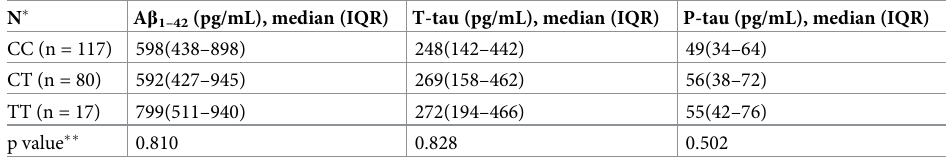
Table 4. Association between CSF biomarkers and rs5848 genotype.